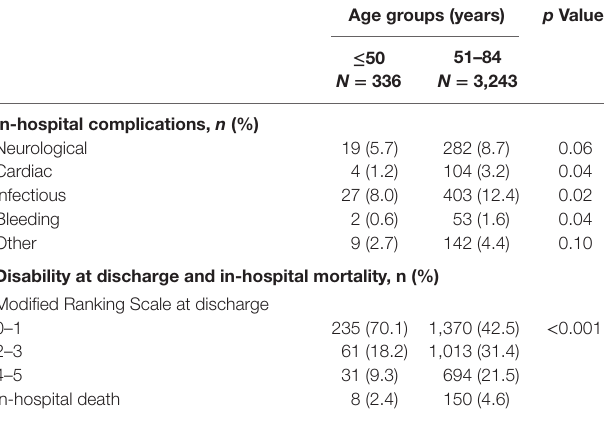
TaBle 3 | Outcomes of first ischemic stroke by age